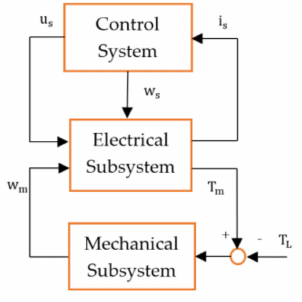
Figure 1. System architecture block diagram.